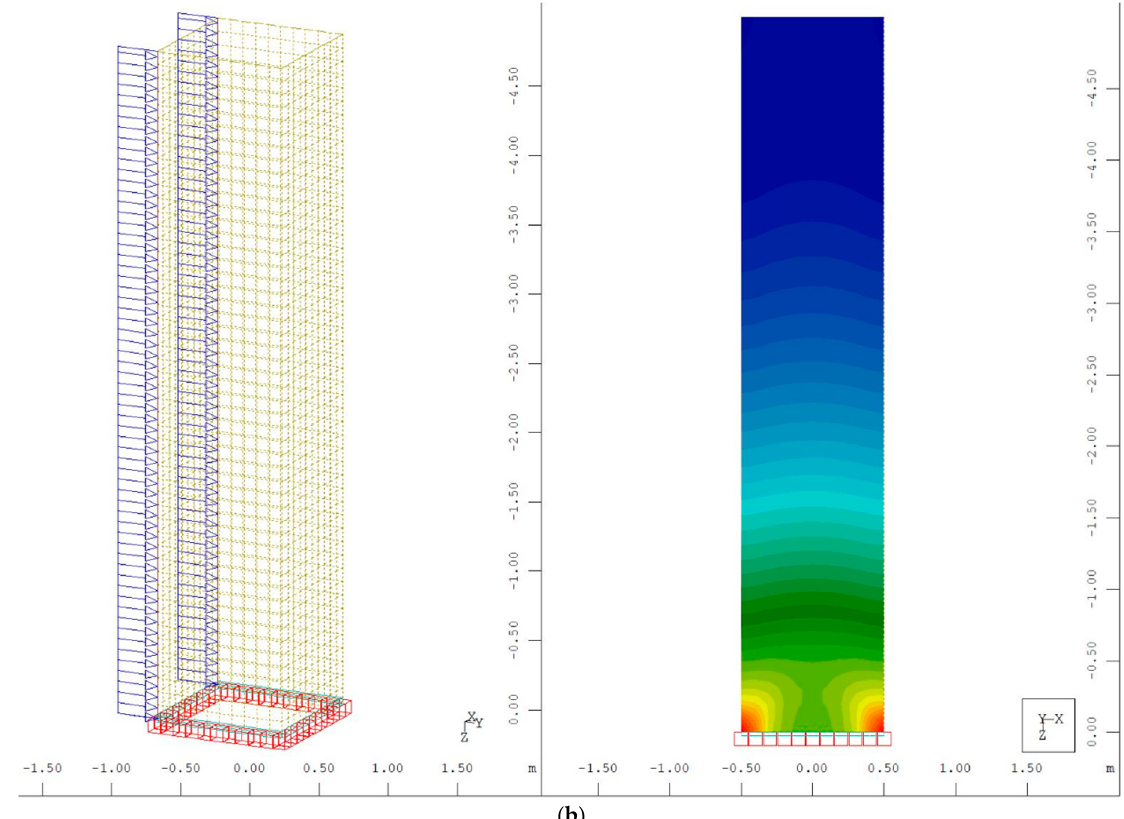
Figure 3. ( a ) Box section cantilever stress distribution for point load and ( b ) continuous load.